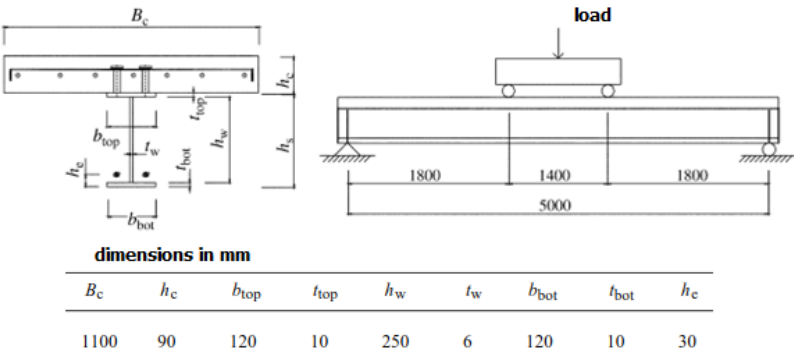
Figure 3. Test setup of the 5 m span prestressed steel-concrete composite beam. Source: Chen and Gu